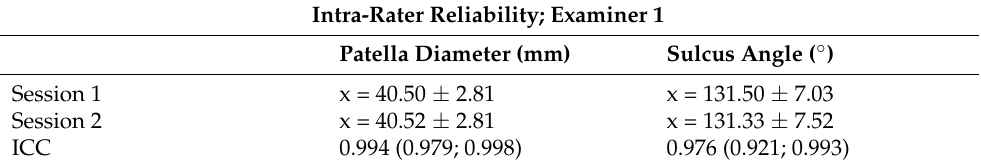
Table 2. Results of the patella diameter and sulcus angle measured in the right knee by the experi- enced examiner during the first and second measurement sessions. The intra-rater reliability for the experienced examiner.